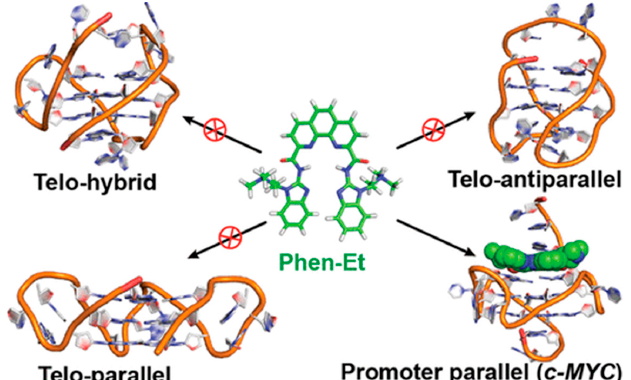
Figure 4. Molecular structures of the selective G4 binders of the phenanthroline family reviewed here: ( a ) [55], ( b ) [57], ( c ) [58], ( d ) [59], ( e ) [63], ( f ) [64], ( g ) [65] and ( h ) [66]. Red letters evidence parallel G4s’ high selectivity, blue letters correspond to molecules selective for antiparallel to- pology, and the systems with other/mixed behaviour have black lettering (absent here).